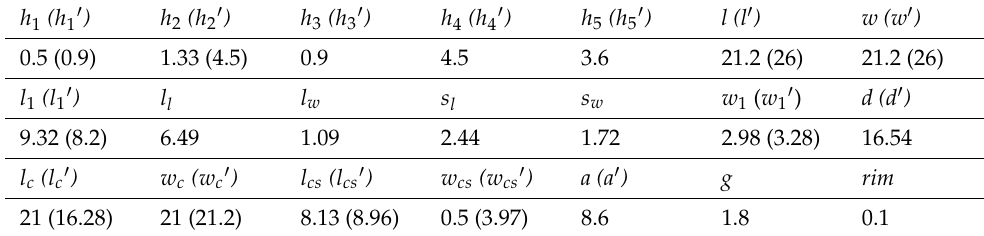
Figure 3. Amplitude distribution of the E -field for TE 220 mode in the cavity. Table 1. Dimensions of the 2 × 2-element subarray (unit: